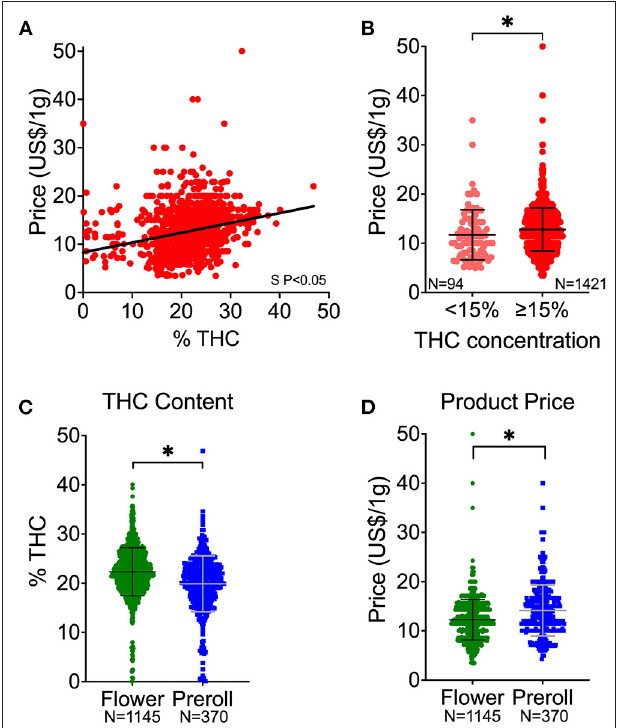
FIGURE 2 | Flower and preroll cannabis potency (THC content) and price associations. (A) THC and price correlation of flower products. (B) Price distribution of flower products with < 15% THC in comparison to flower products with ≥ 15% THC. (C) THC and price correlation of preroll products. (D) Price distribution of preroll products with < 15% THC in comparison to preroll products with ≥ 15% THC. S P < 0.05 denotes significantly non-zero slope (A,C) . * P < 0.05 between the mean values of the groups (B,D) by Welch’s t -test (unpaired, two-tailed). Data shown as mean ± SD (B,D)